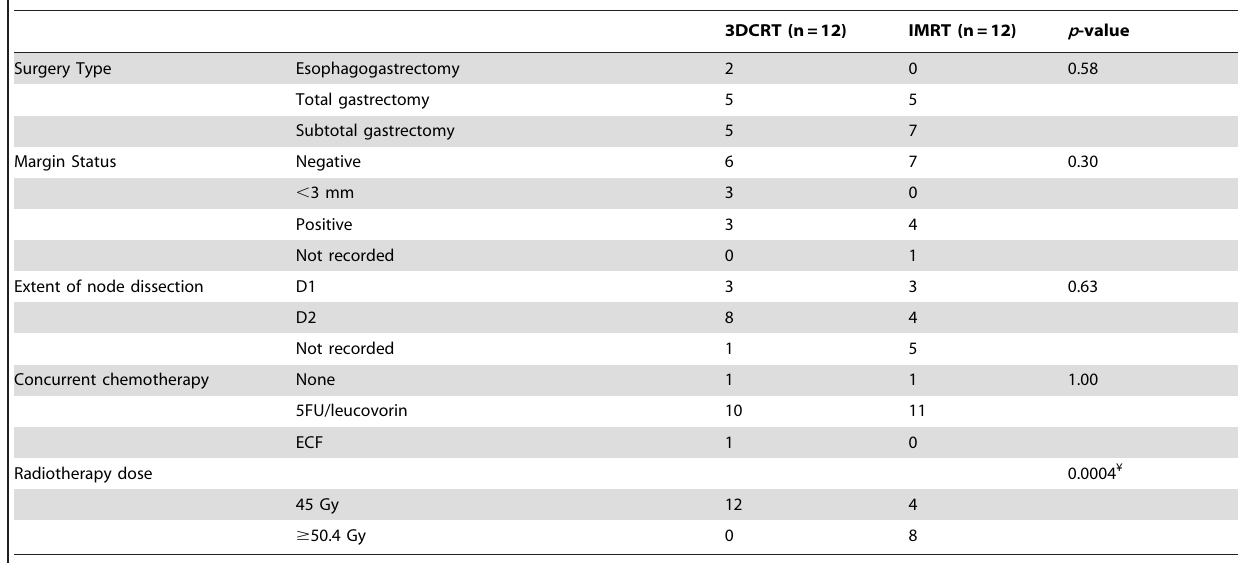
Table 2. Treatment Characteristics.